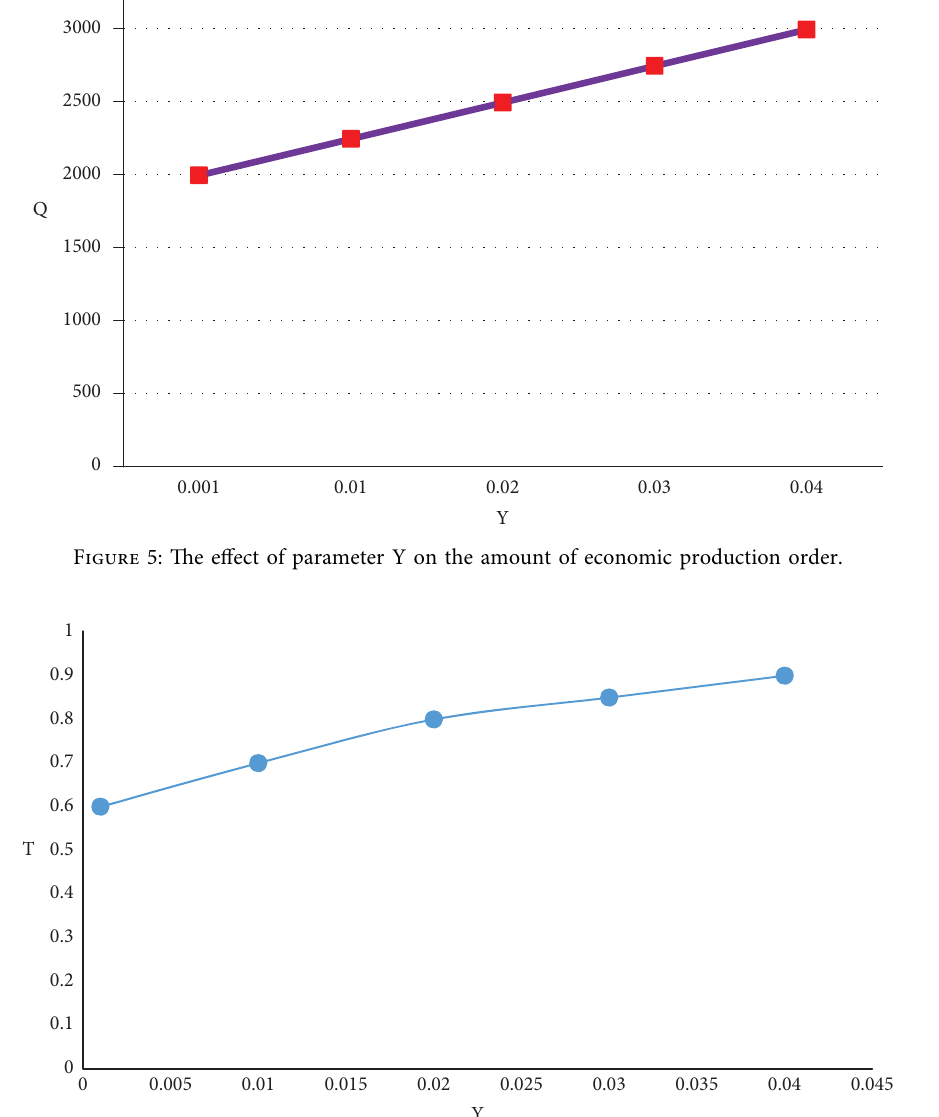
Figure 6: Te efect of parameter Y on the time of economic production order.